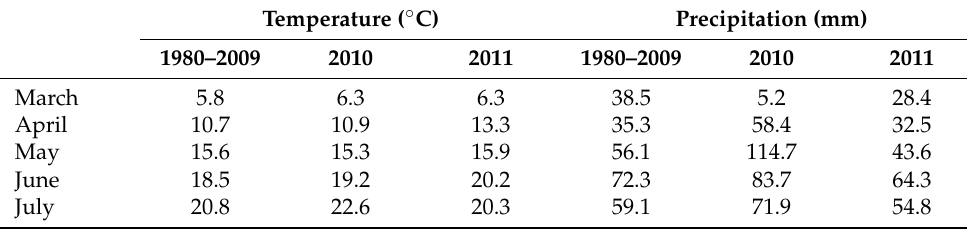
Table 1. Mean temperature and mean precipitation during growing seasons and long-term